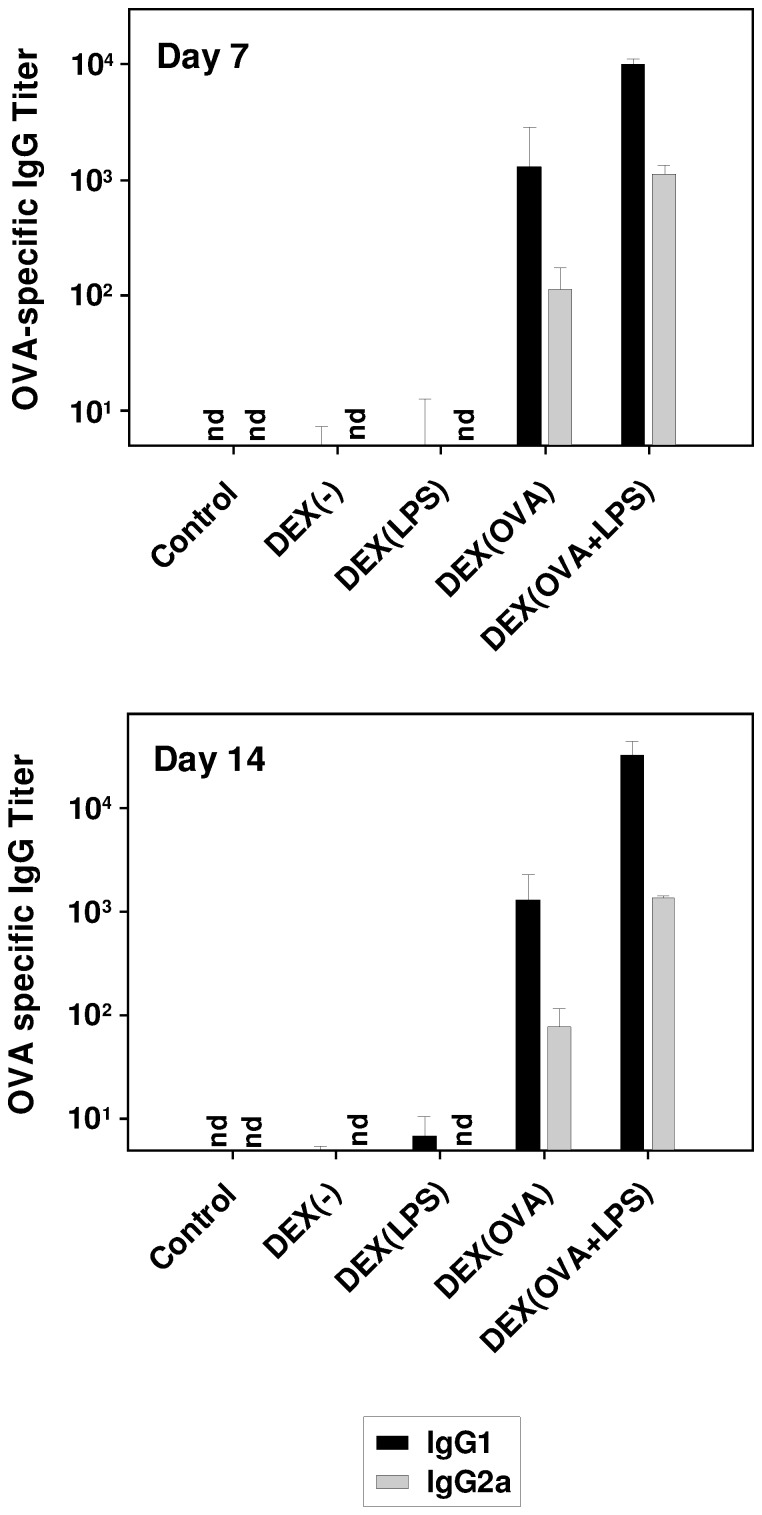
DEX particles containing OVA elicit a specific Th2-biased humoral immune response, augmented upon codelivery of LPS.Naive C57BL/6 mice (two mice per group) were immunized with DEX particle formulations as indicated. On days 7 (upper panel) and 14 (lower panel), mice were bled and derived sera were used for detection of OVA-specific IgG1 and IgG2a antibody titers. Data represent mean±SEM of two sera per group.